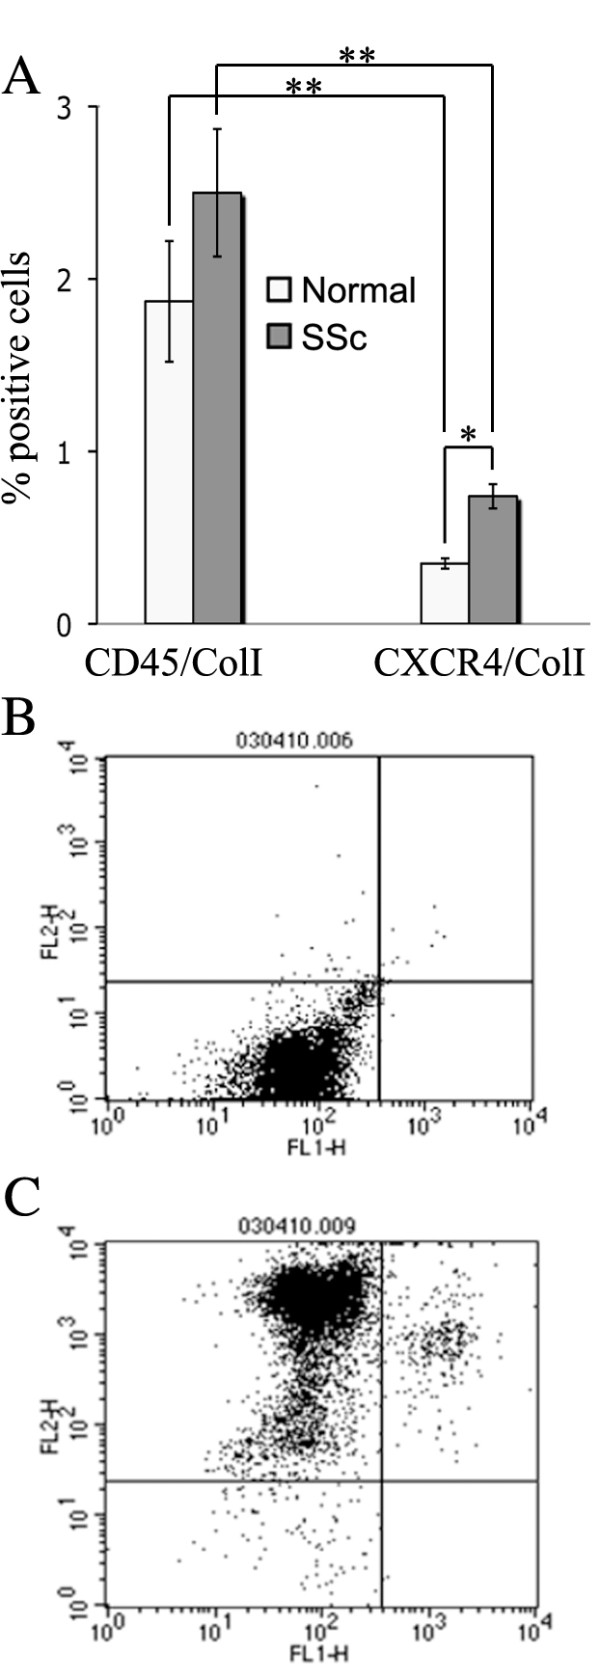
Fibrocyte subsets in the peripheral blood of SSc-ILD patients and normal subjects. Human peripheral blood mononuclear cells (PBMCs) were isolated and analyzed by flow cytometry for CD45, CXCR4 and ColI. Seven patients and seven normal subjects were used in these studies. (A) Note that the number of CD45+/ColI+ and CXCR+/ColI+ cells is higher in SSc-ILD blood than in normal blood. Note that CD45+/ColI+ fibrocytes are much more prevalent than CXCR4+/ColI+ cells. **P < 0.01. *P < 0.05. (B) and (C) Primary data demonstrating that fluorescence levels provided by isotype controls are readily distinguished from fluorescence levels provided by specific antibodies. For FL1 fluorescence, primary antibodies are biotinylated isotype controls (B) and biotinylated rabbit anti-ColI (C). For FL2 fluorescence, antibodies are isotype control phycoerythrin (PE) (B) and anti-CD45 PE monoclonal antibody (C).